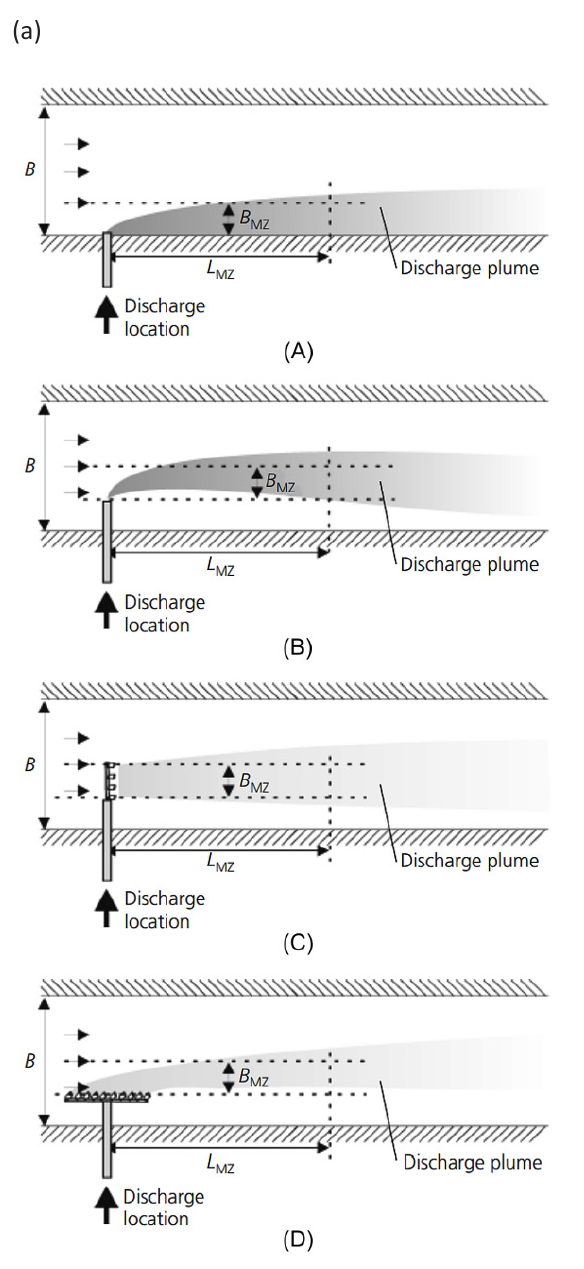
Figure 1: (a) Examples of mixing zone for river discharges: (A) a traditional shoreline discharge, (B) a submerged offshore single-port discharge, (C) a regular perpendicular diffuser design and (D) a diffuser design for navigating rivers or rivers with other cross-sectional limitations. B – the width of mixing zone, L – the length of the mixing zone downstream. B MZ MZ specified in the water legislation [4]. (b) Photo of a fragment of the discharge installation damaged by sediment (after